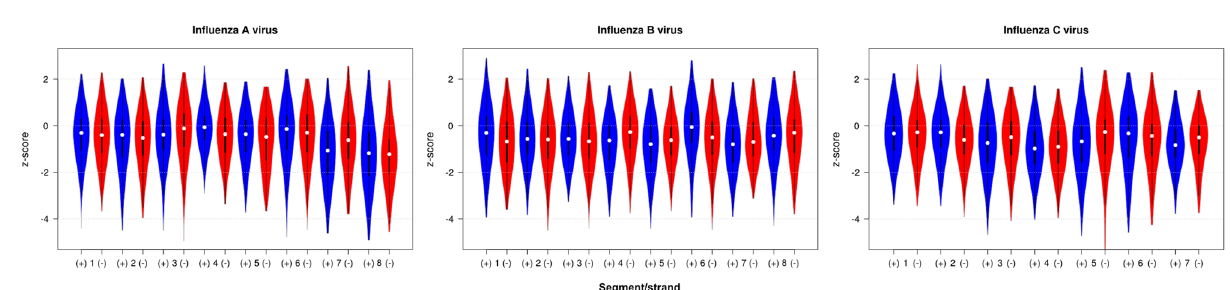
Figure 1. z-score violin plots of each influenza virus, with positive (blue) and negative (red) strands for comparison. While the range of z-scores observed is broad, there is a visual trend toward the negative (structured) across all clades, with IAV segments 7 and 8 being noticeably lower than other segments. Data from ScanFold , 120 nt window, 1 nt step, 100 randomizations, 37 ˚C. Image adapted from BoxPlotR